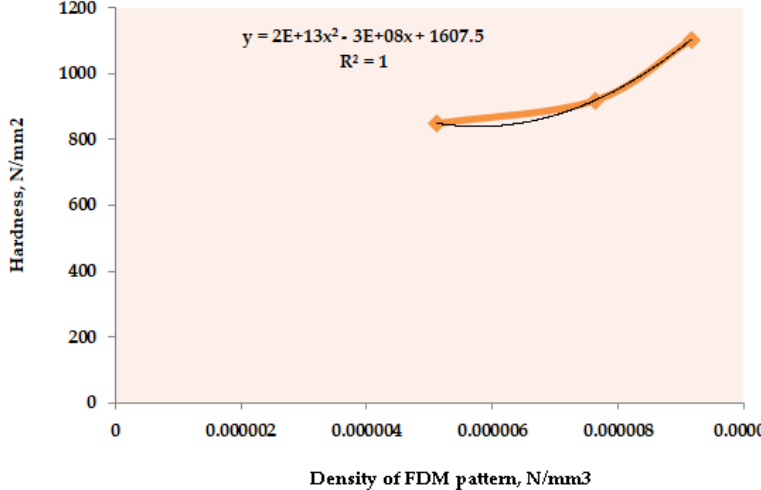
Figure 4. Hardness versus density of fused deposition modelling (FDM) pattern plot.